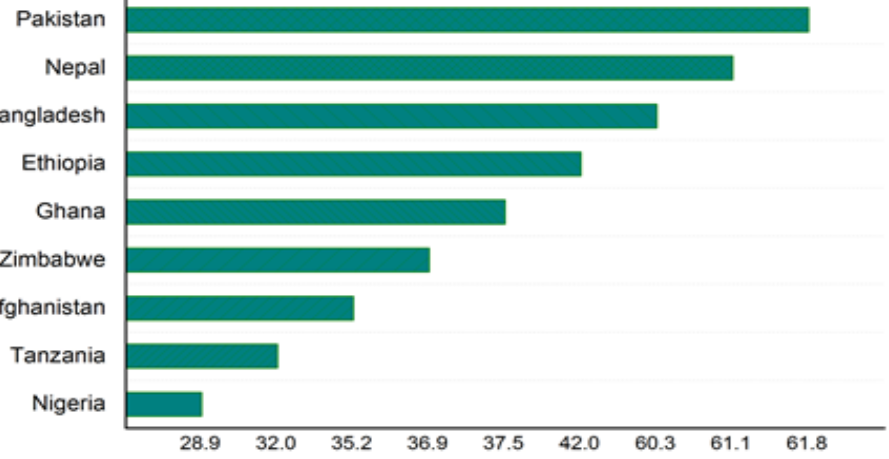
Figure 5. Neonatal mortality as proportion of the under ‐ five mortality rate, according to the latest DHS.